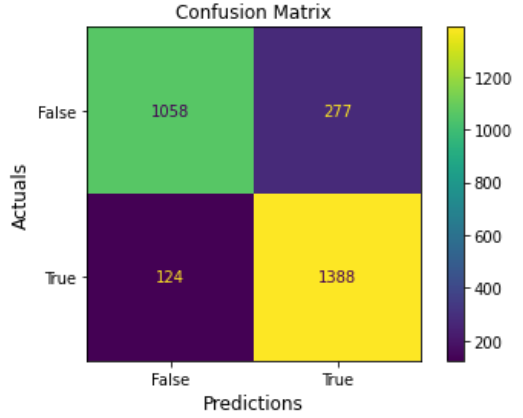
Figure 5. Confusion matrix of classification r esults.